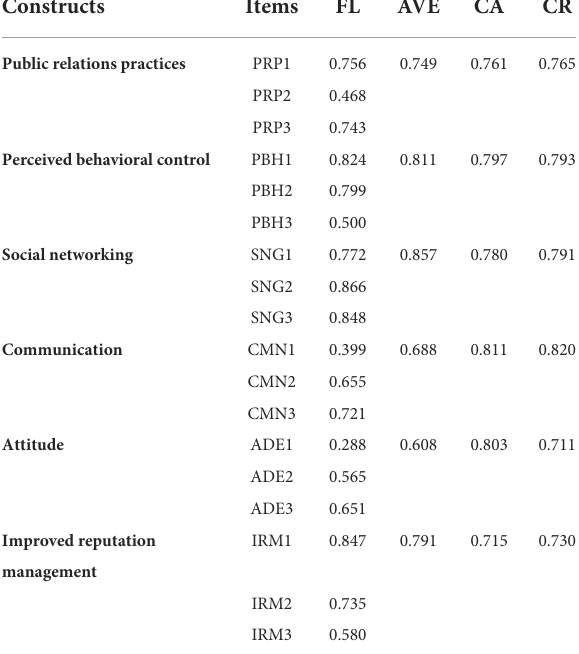
TABLE 5 Coefficients of determination R 2